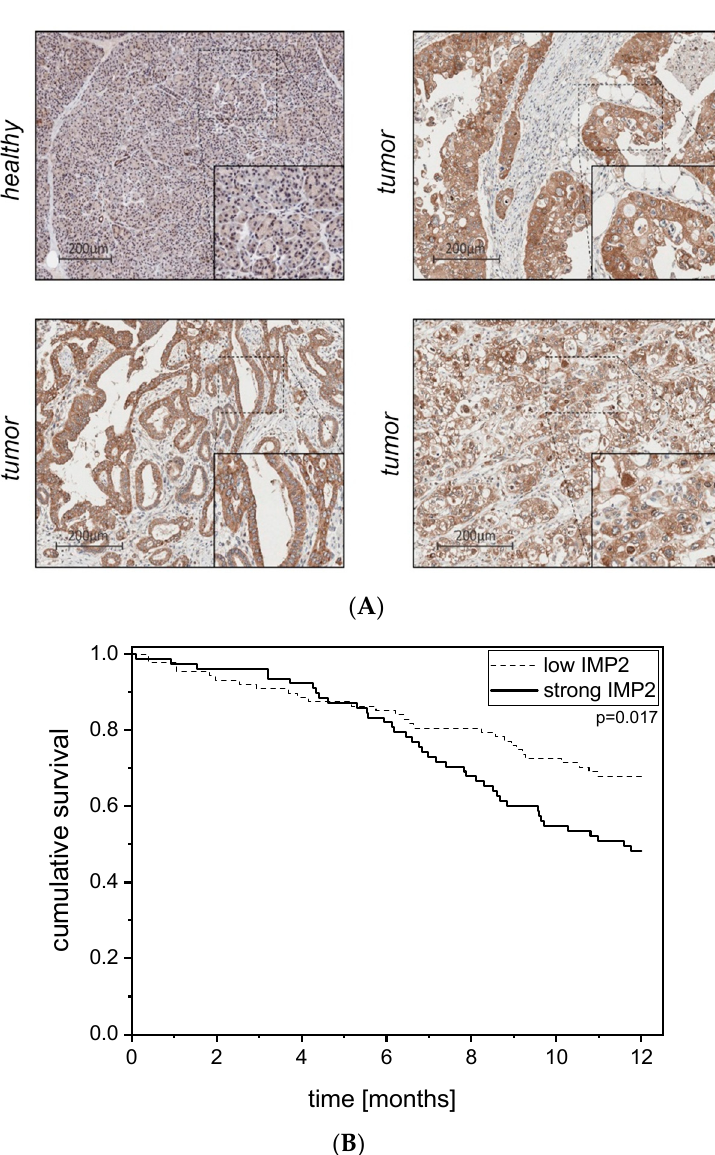
Figure 3. IMP2 protein is linked to poor one-year survival. ( A ) Tissue microarrays of PDAC sample collection from n = 210 PDAC patients (tumor tissue: n = 210 healthy tissue: n = 11) were analyzed by immunohistochemistry. IMP2 was significantly overexpressed in tumor tissue ( p = 0.26 × 10 − 4 ). In healthy tissues IMP2 immunoreactivity was found in 91% of samples (score 0: 9%; score 1: 55%; score 2: 27%; score 3: 9%). All tumor tissues ( n = 204) were positive for IMP2 expression: score 1: 7.4%; score 2: 40%; score 2 / 3: 2.9%; score 3: 49.5%); ( B ) Kaplan-Meier analysis of one-year survival of patients with strong IMP2 staining (score 3) versus low IMP2 staining in pancreatic tumor tissues.